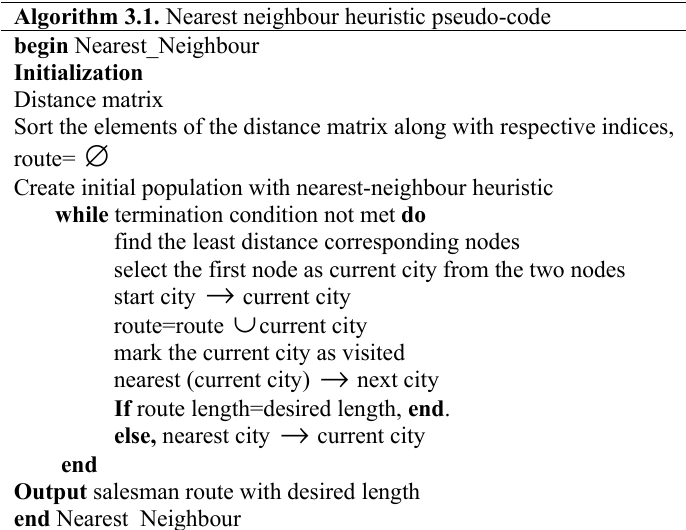
Algorithm 3.1. Nearest neighbour heuristic